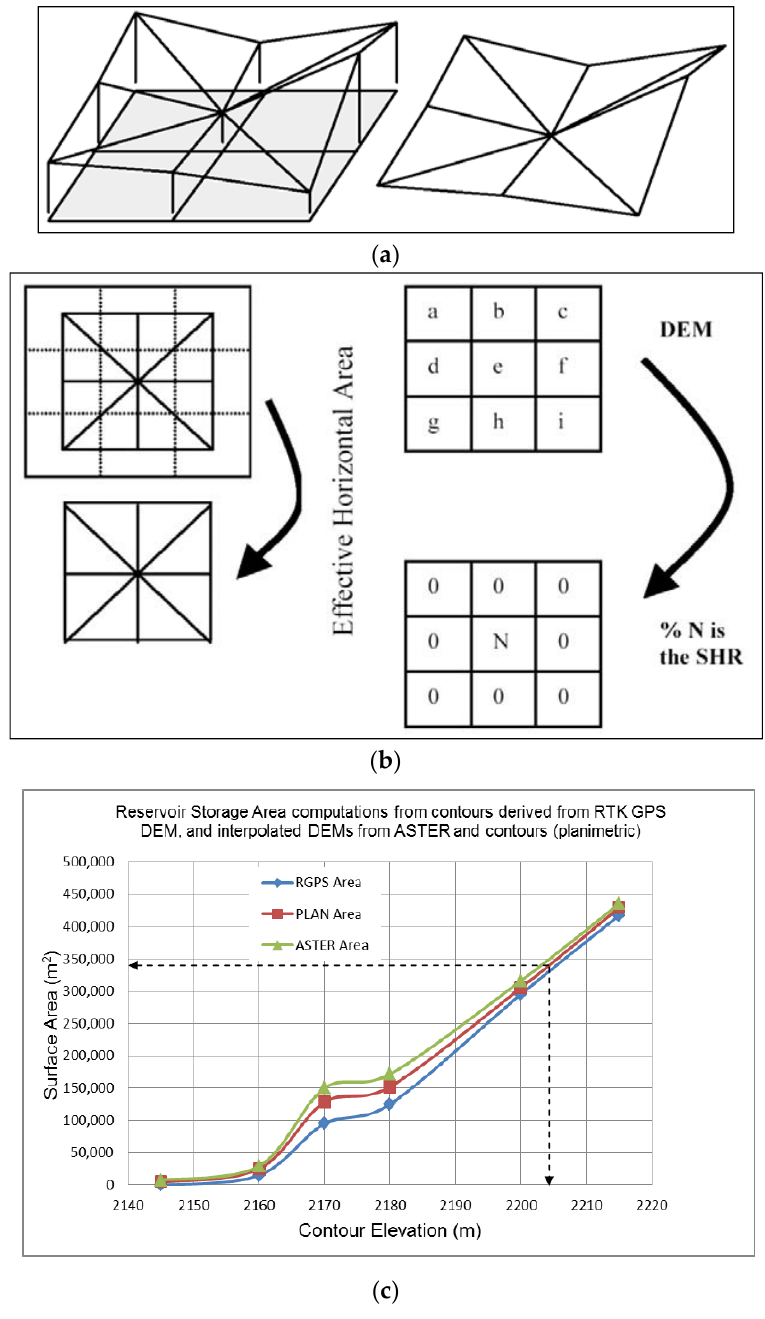
Figure 10. ( a ) Pixel base ( left ) and corresponding surface ( right ) in a DEM; ( b ) 3 × 3 moving window for Surface to Horizontal area Ratio ( ) SHAR calculation; ( c ) Resulting reservoir surface area versus elevation as derived from high-resolution GPS DEM and as interpolated from Advanced spaceborne Thermal Emission and Reflection Radiometer (ASTER) and contour (PLAN) based observations.